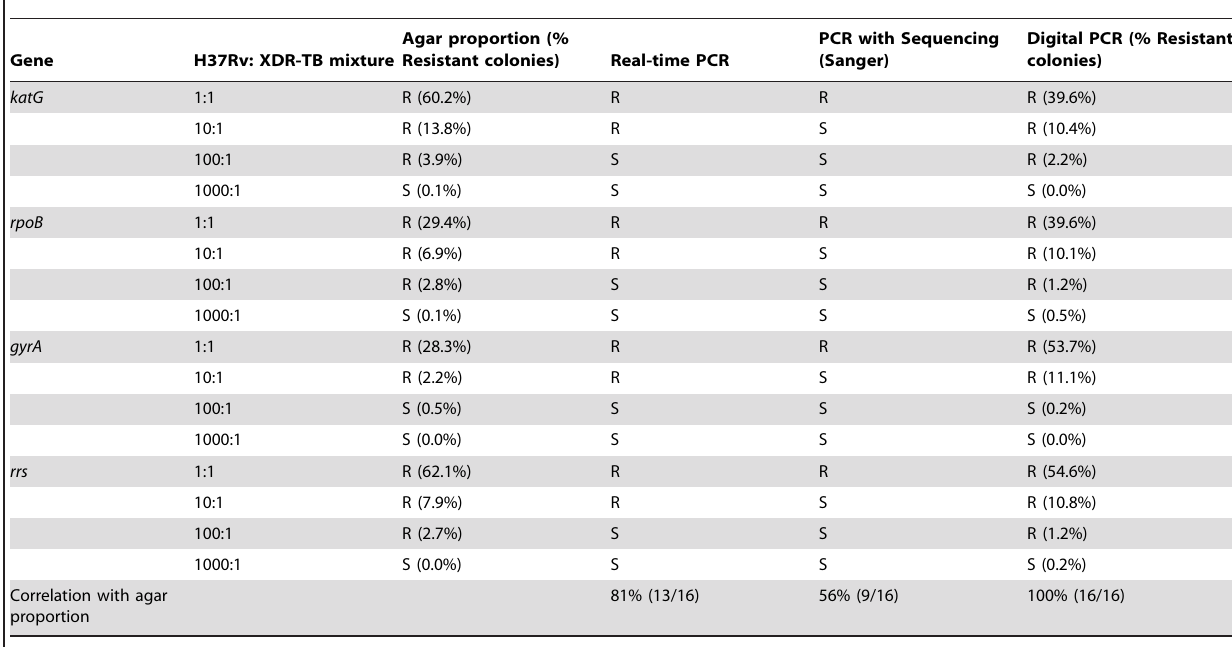
Table 3. Comparison of digital PCR, agar proportion, real-time PCR, and PCR with Sanger sequencing.